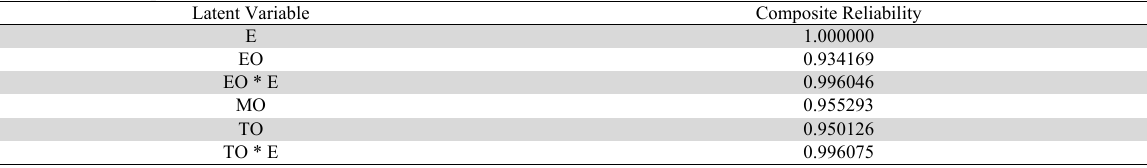
Summary of composite reliability calculation Latent